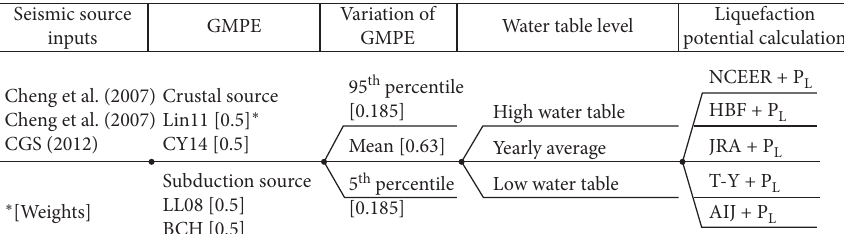
Figure 1: Logic tree used in the HAZ45PL module.